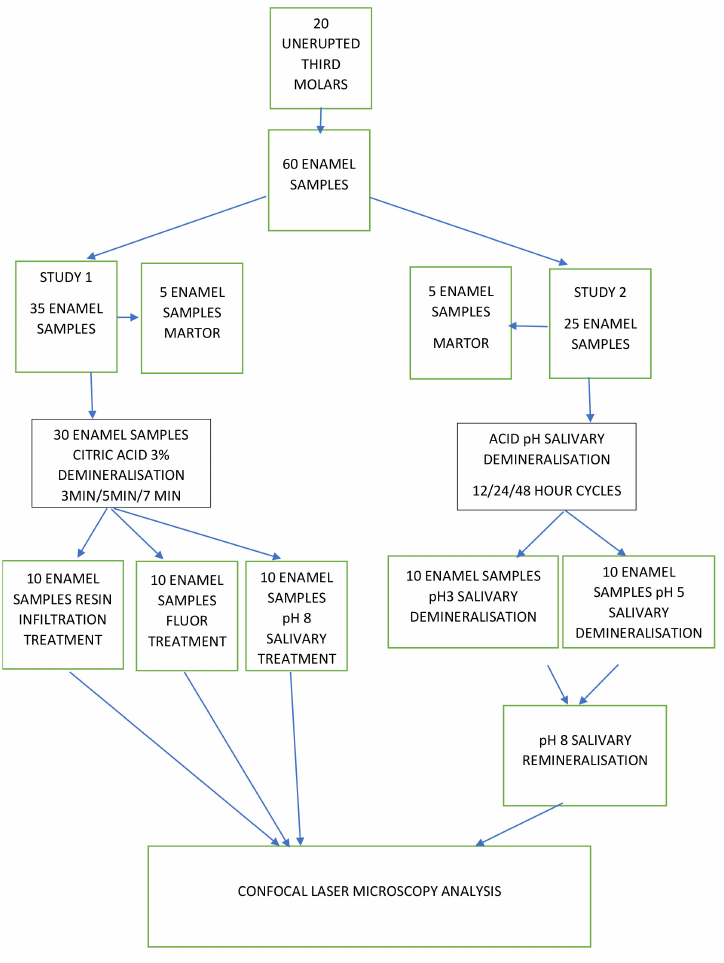
Figure 1. Diagram of the study